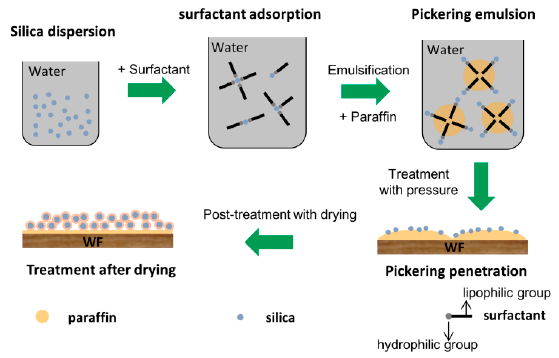
Figure 1. Schematic illustration for Pickering emulsion preparation and wood flour (WF) treatment.